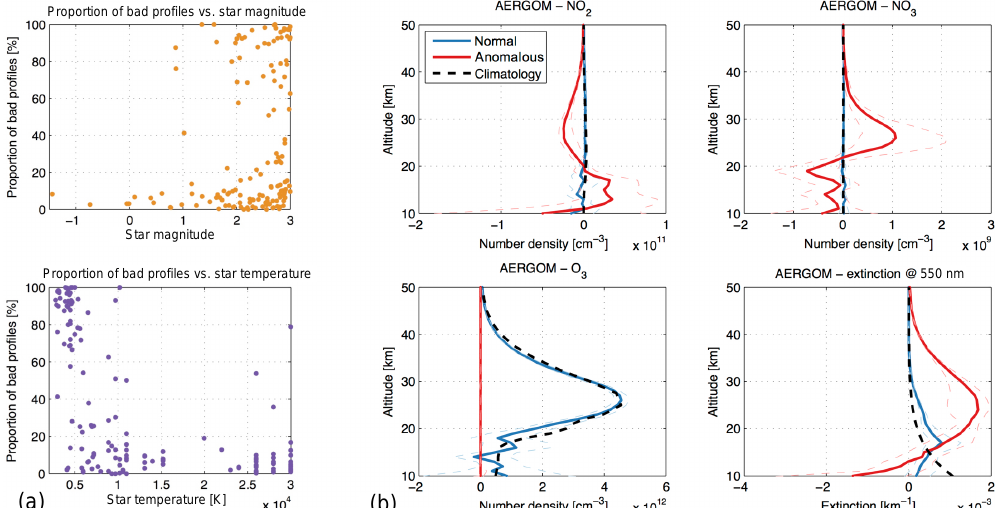
Figure 1. (a) Proportion of anomalous profiles as a function of star temperature and magnitude. (b) Median gas and aerosol extinction profiles for normal and anomalous AerGOM retrievals calculated using 200